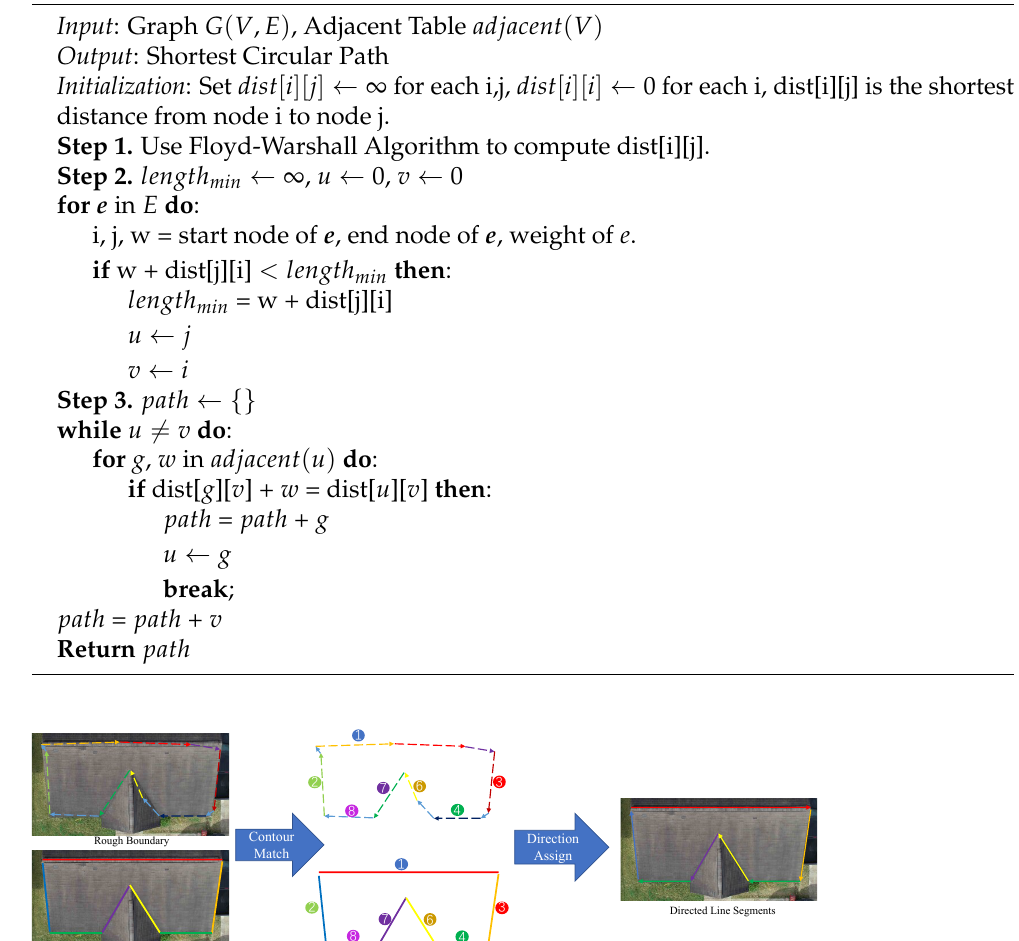
Algorithm 1 Shortest Circular Path Algorithm